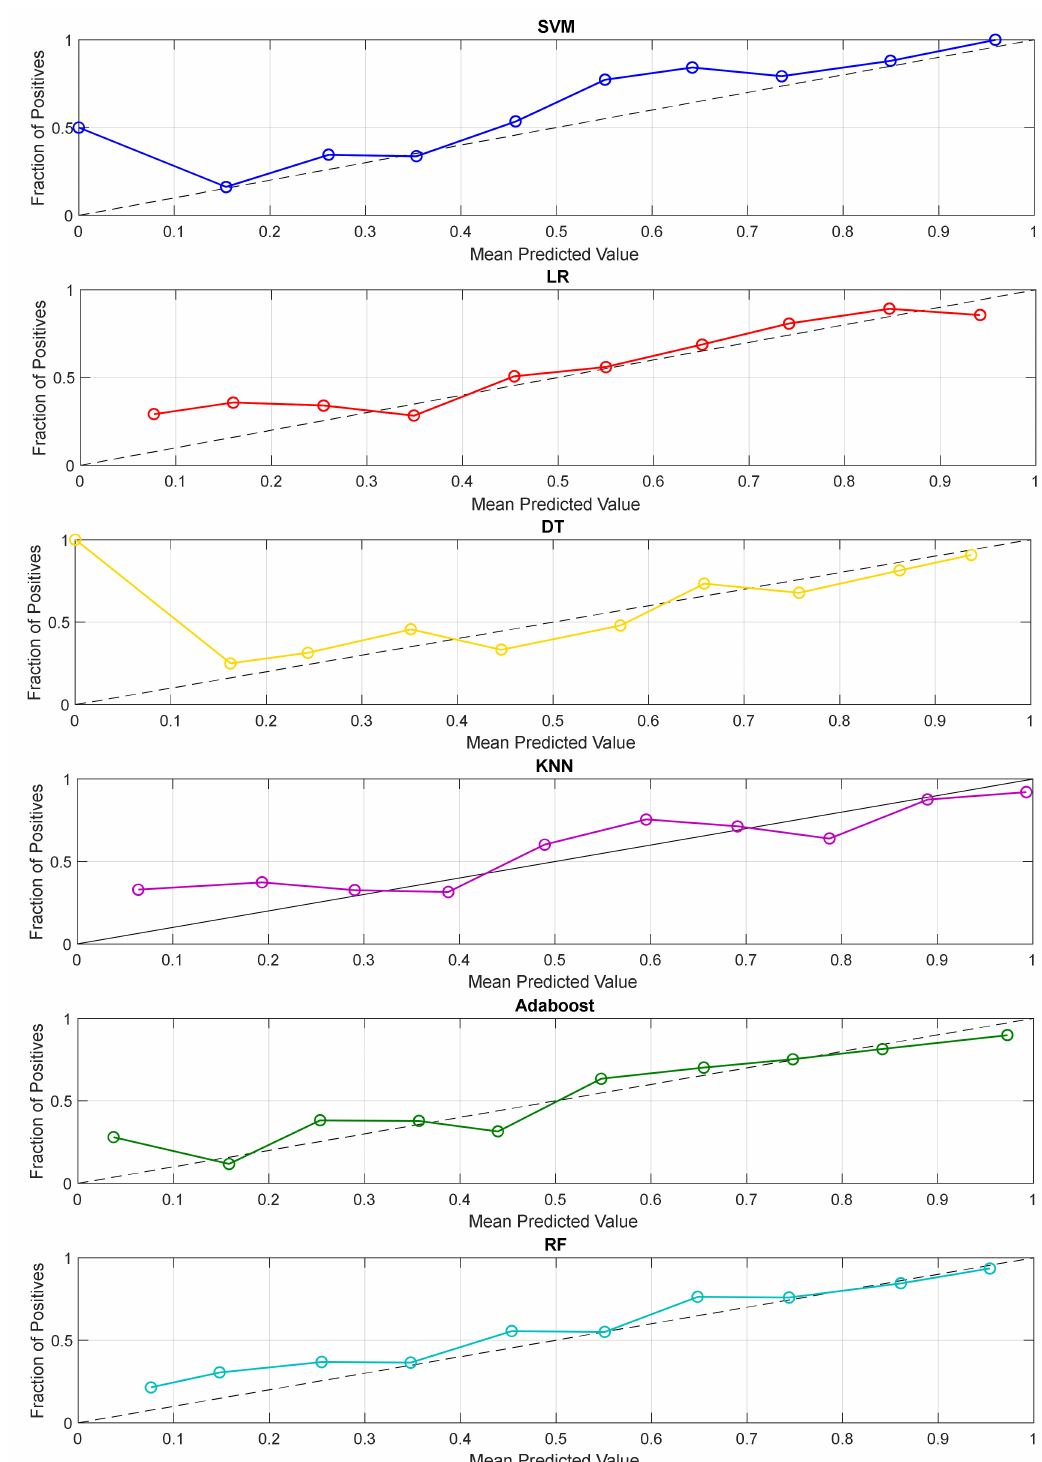
Figure 4. Reliability diagrams of the competing ML models. Having accomplished the best accuracy (0.7466), the highest AUC (0.7793), the second highest precision (0.7968), fourth sensitivity (0.7956), second reliability performance